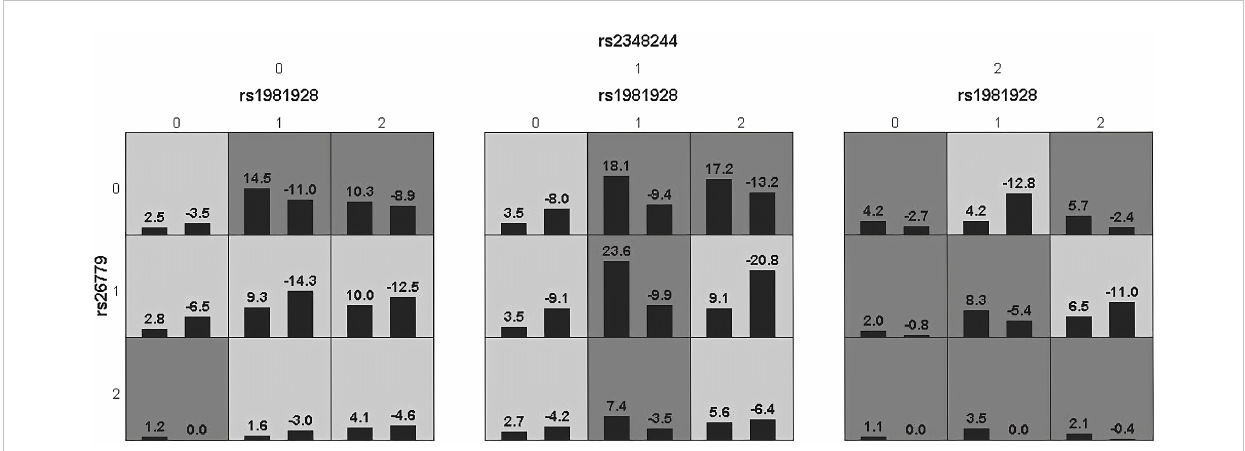
FIGURE 3 Epistatic interaction for HCC involving rs1981928, rs26779, rs2348244 between HCC and SC group.Rs1981928(0,1,2)=rs1981928 (TT, TA, AA); rs26779(0,1,2)=rs26779 (CC, CT, TT); rs2348244(0,1,2)=rs2348244 (TT,TC,CC).The scores of HCC group (left black bar in boxes) and SC group (right black bar in boxes) are shown for each genotype combination.